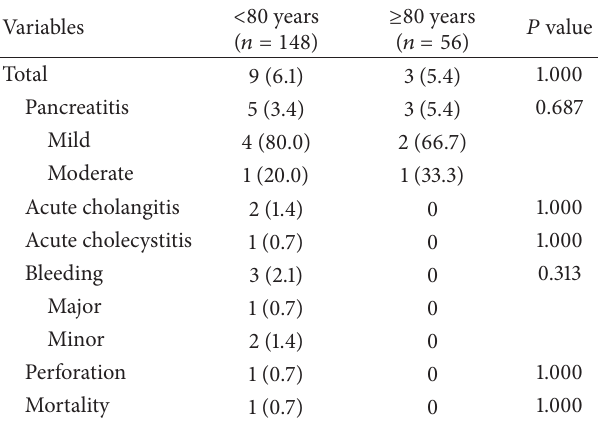
Table 3: Postprocedural adverse events between two